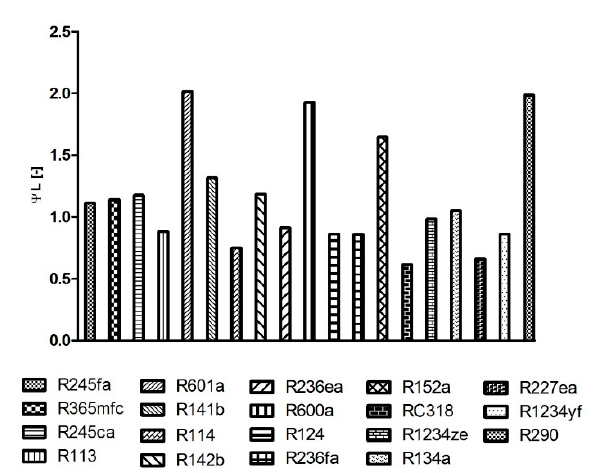
Figure 18. The variation of the ψ L rating parameter (graph is valid for the heat sink temperature of t c = 20 °C).